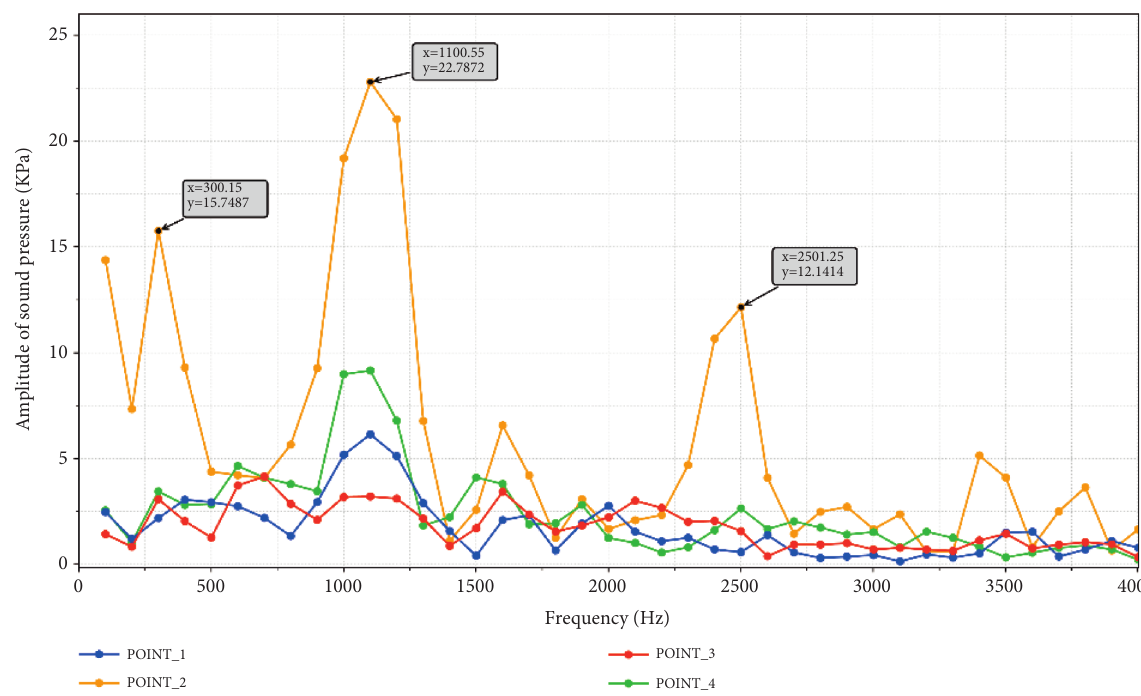
Figure 15: Frequency spectrums of P1, P2, P3, and